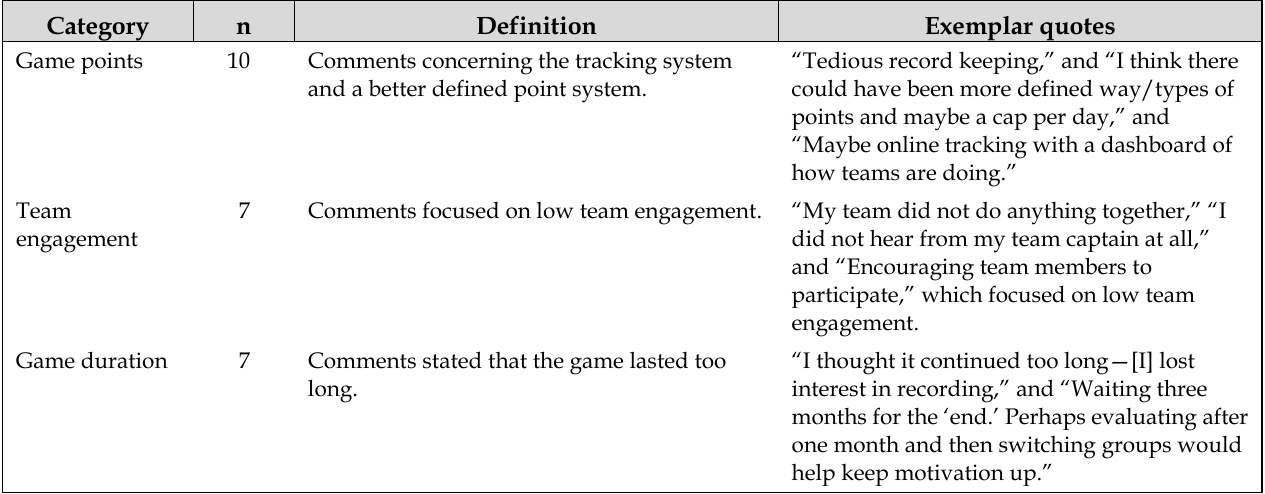
Table 6 Qualitative categories for “What did you enjoy least about the